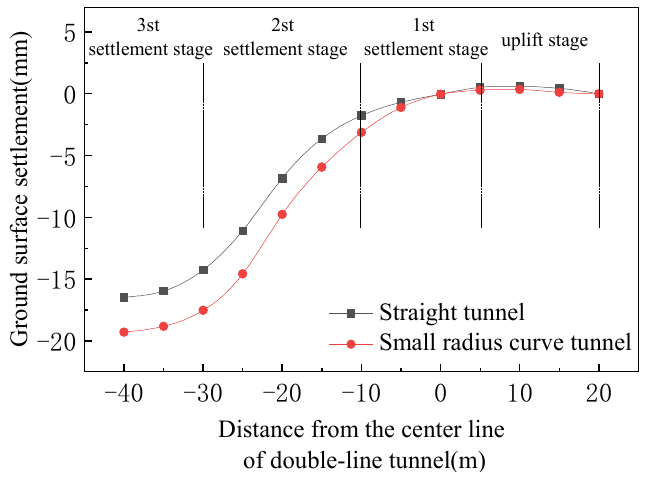
Figure 10. Variation curve of ground settlement and distance from the shield